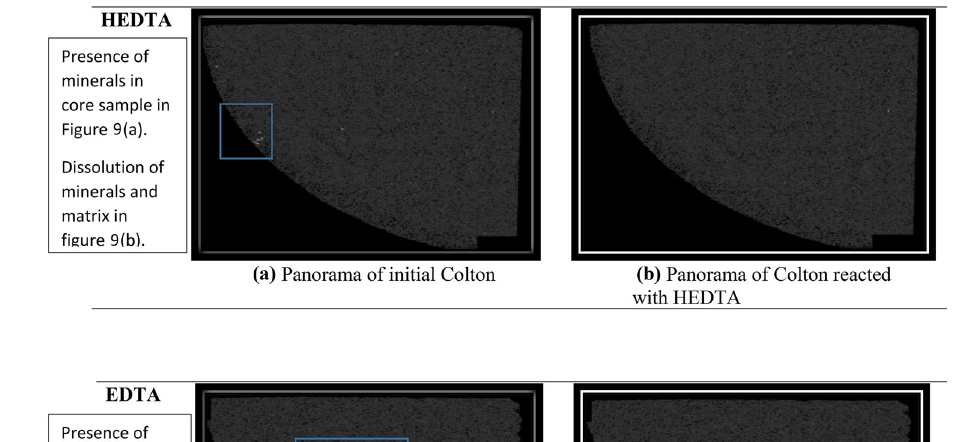
Fig. 9 a Panorama of initial Colton. b Panorama of Colton reacted with HEDTA